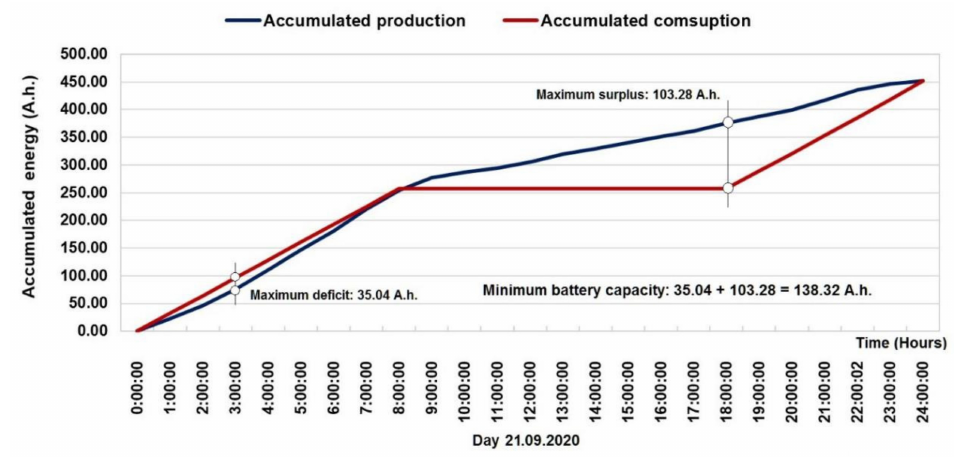
Figure 14. Net available energy balance (generated vs. consumed) and the contribution of supplement energy stored in batteries to ensure that the balance was always